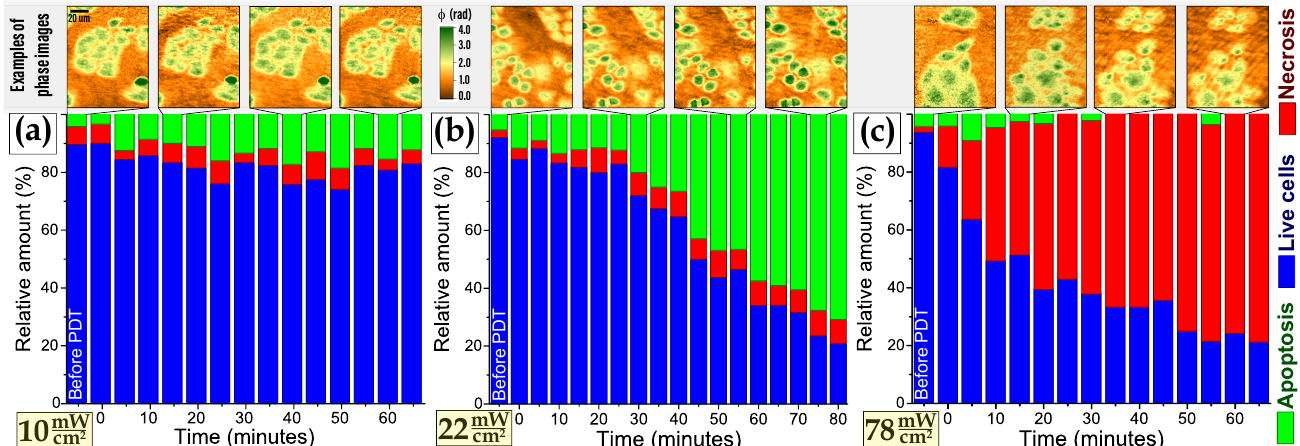
Figure 5. Relative amounts of live, apoptotic and necrotic HeLa cells after PDTr at different power densities of laser radiation calculated using cell classification algorithm based on SVM classifier: ( a ) 10 mW/cm 2 , ( b ) 22 mW/cm 2 , ( c ) 78 mW/cm 2 . First bar at each temporal dynamics represents cell states before irradiation. Time is counted from the end of PDTr. Examples of corresponding phase images obtained at different time moments are shown in the top row above each